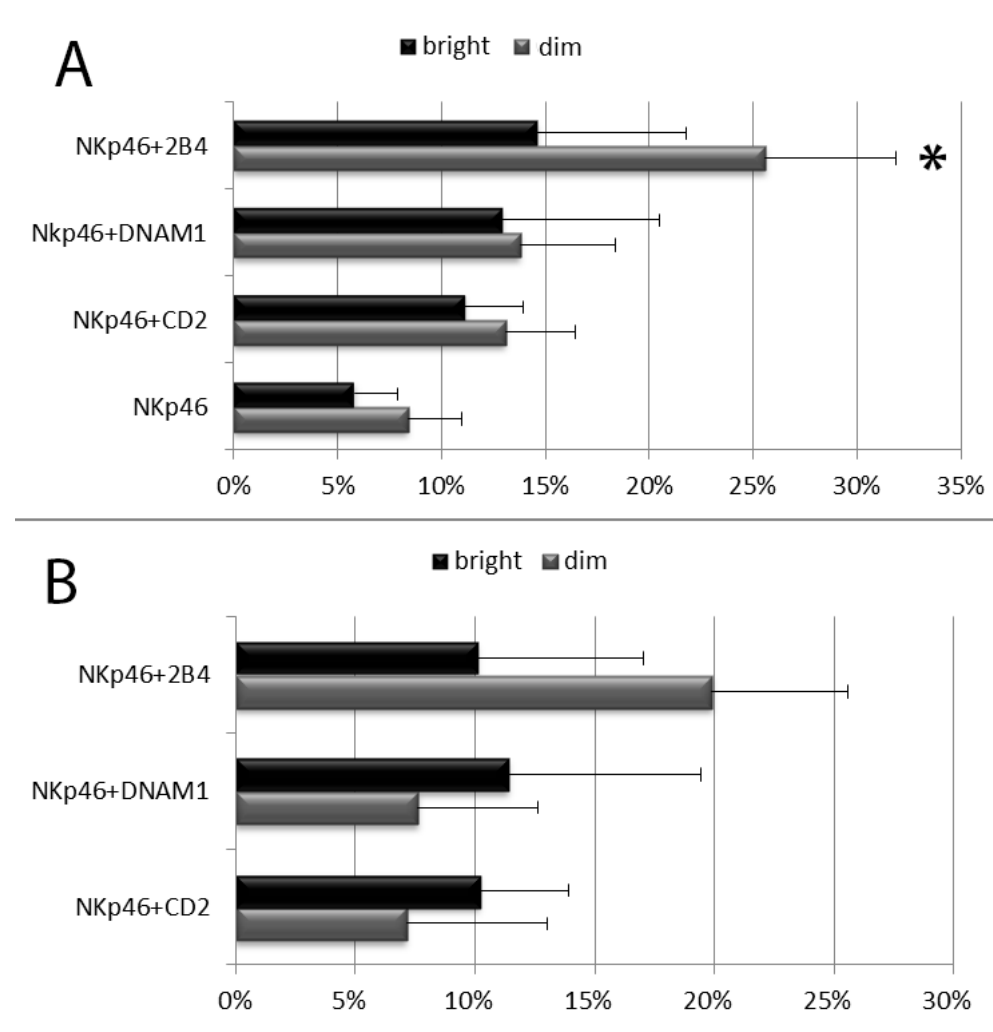
Figure 3. Degranulation analysis of resting CD56 dim and CD56 bright NK cells after stimulation with the indicated mAb combinations. ( A ) Percentages of degranulating NK cells. ( B ) Percentage increment of CD107a mean fluorescent intensity on degranulating NK cells stimulated with the indicated combinations respect to anti-NKp46 alone. Data represent mean +/- SD of at least 5 experiments. Bars indicate SD. * p < 0.05 relative to NK cells stimulated with anti-NKp46 mAb-coated beads within its NK cell subset.